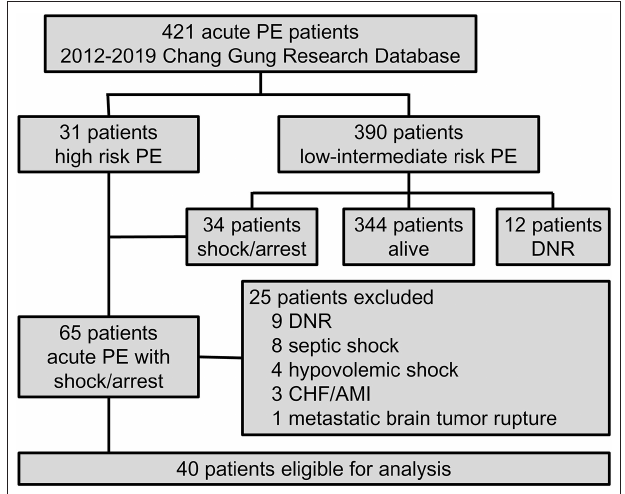
FIGURE 1 | Flow chart of inclusion and exclusion criteria of this cohort study of Chang Gung Research Database from 2012 to 2019. AMI, acute myocardial infarction; CHF, congestive heart failure; DNR, do-not-resuscitate; PE, pulmonary embolism.